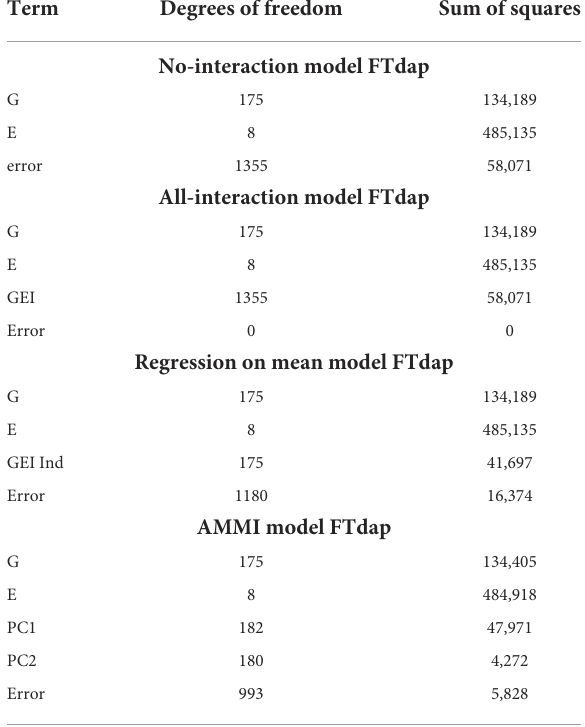
TABLE 9 Biclustering results with the smallest SSE values obtained from fitting no-interaction models on each bicluster for raw responses (30 trials—rice data FTdap).